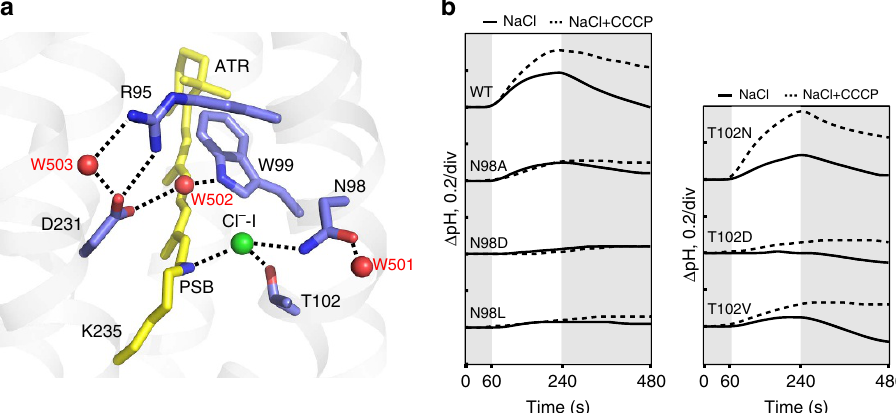
Figure 3 | ClR structure at the PSB region. ( a ) Detailed structure of ClR at PSB. Chloride ion and water molecules are shown by green and red spheres, respectively, and hydrogen bonds are depicted in dashed lines. ( b ) Light-induced pump activities of wild-type (WT) ClR and its mutants at Asn98 and Thr102. The pumping activities are measured in NaCl (lines) and NaCl with carbonyl cyanide m -chlorophenylhydrazone (CCCP; dashed lines). Grey and white sections indicate dark and light conditions,